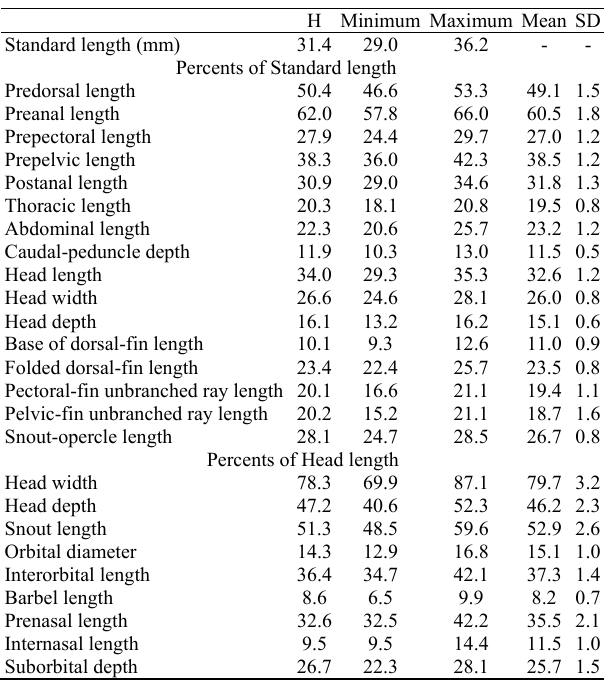
Table 3. Descriptive morphometrics of Rhinolekos garavelloi . Values given for holotype (H; DZSJRP 10479) and range of 30 specimens (DZSJRP 10477, 12191; MCP 44057; MNRJ 34127; MZUSP 103697); range includes holotype. SD = Standard deviation.